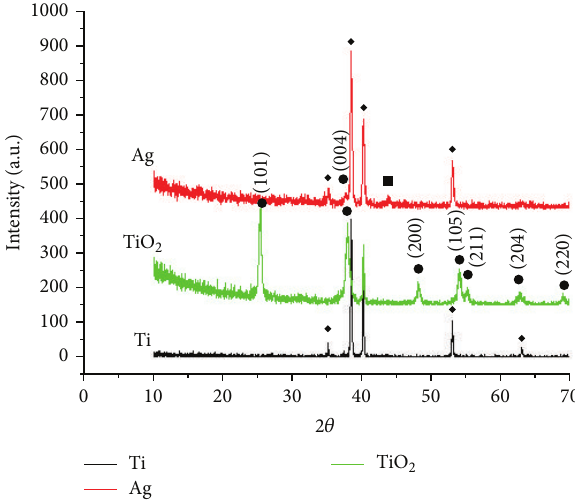
Figure 2: X-ray diffraction patterns of TiO 2 : as-annealed TiO 2 nan- otubes at Group TiO 2 ; Ag: as-annealed Ag doped TiO 2 nanotubes at Group Ag ( X : Ti; e : anatase; ◼ : Ag); Ti: cpTi surface at Group Ti.